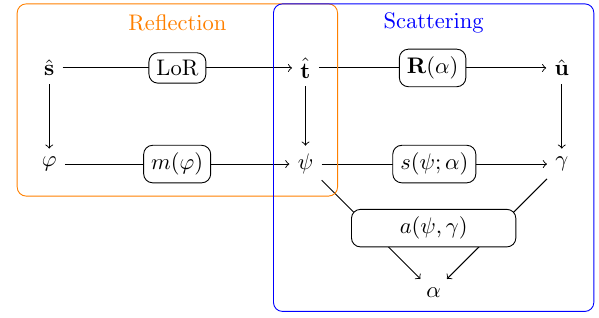
Figure 2. Mappings between unit vectors and angles.